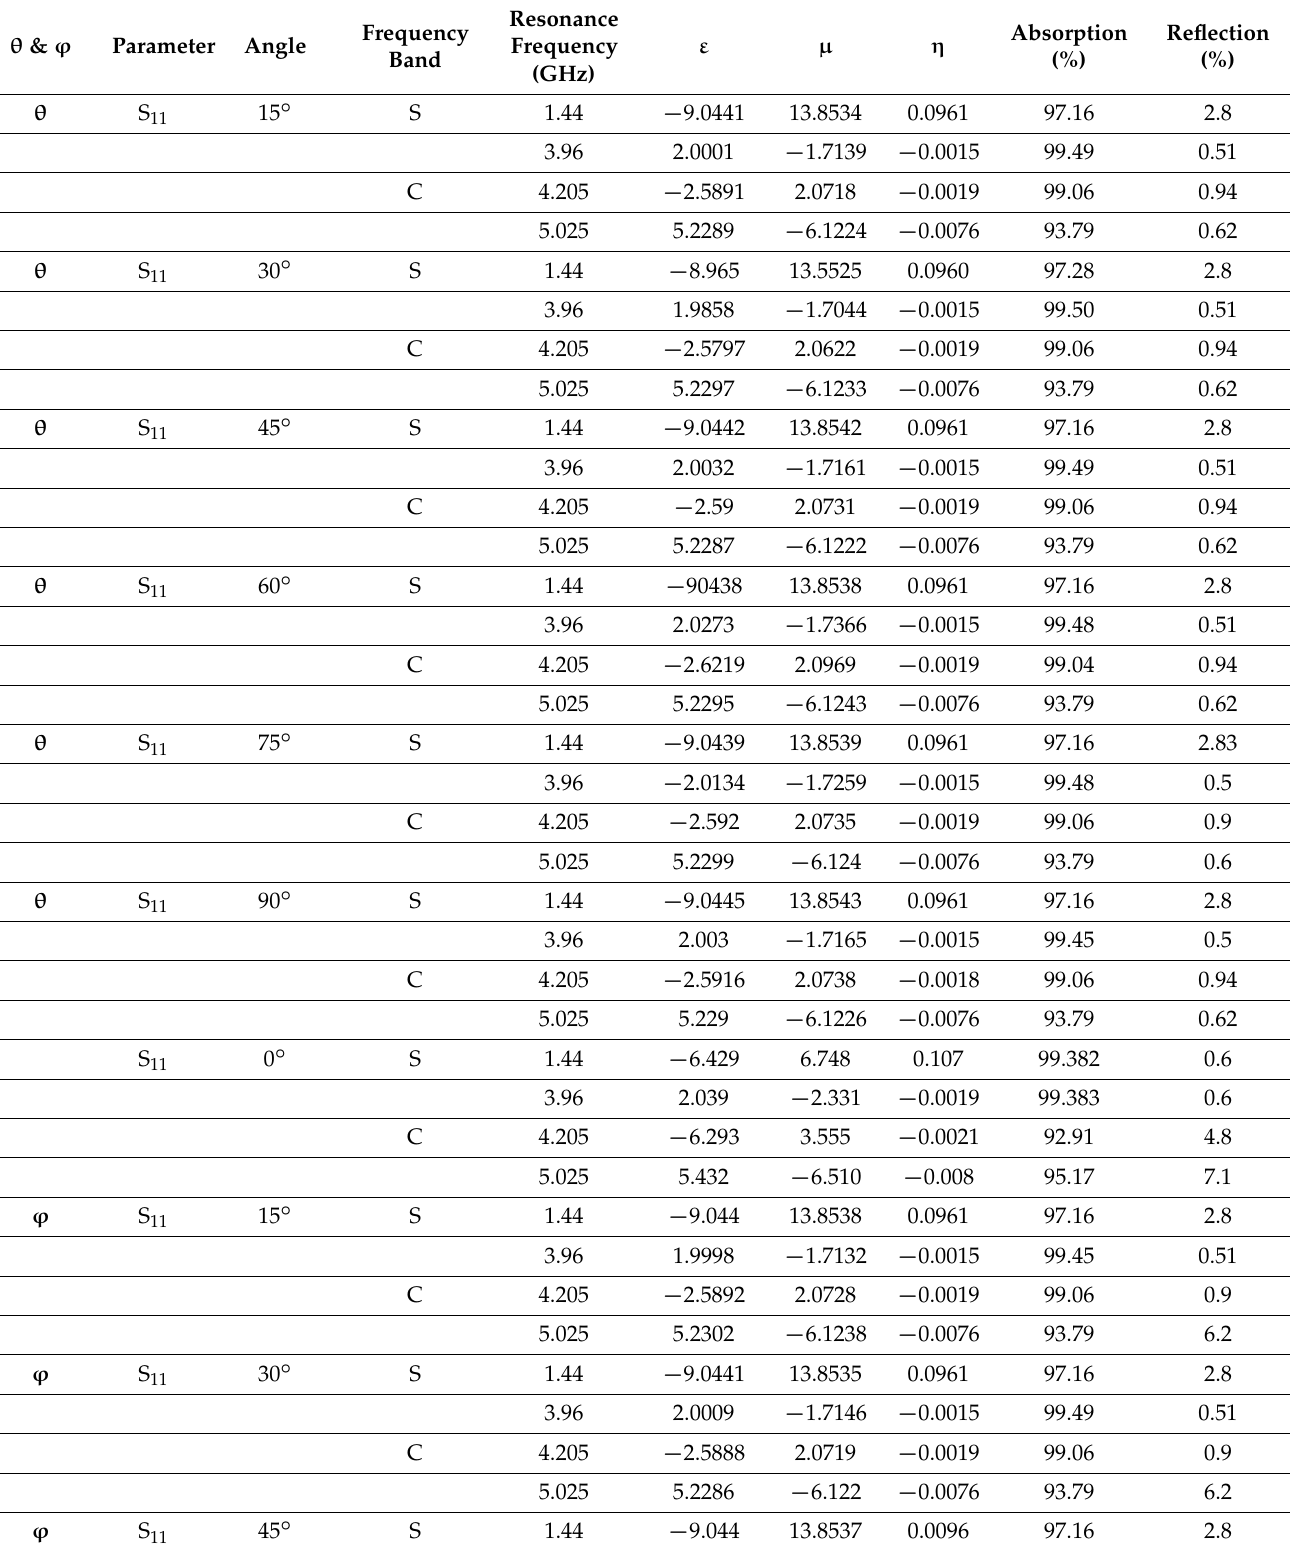
Table A2. Permittivity, permeability, and reflective index at S 11 and S 21 of Rogers4450B substrate at different polarization angles of θ and ϕ